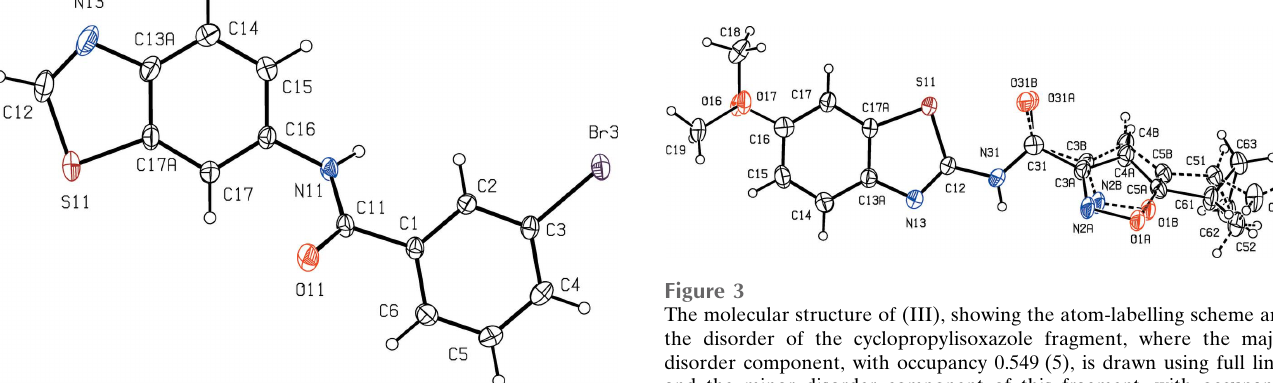
Figure 1 The molecular structure of (I), showing the atom-labelling scheme. Displacement ellipsoids are drawn at the 30% probability level.